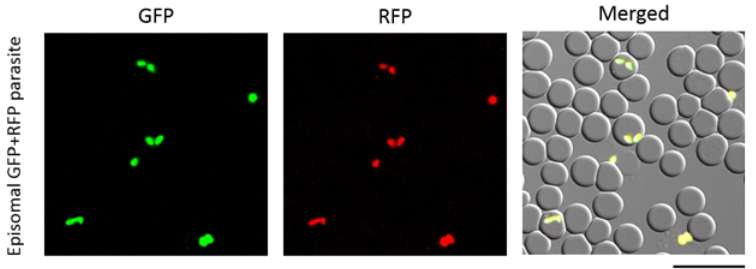
Fig 2. Live fluorescence images of B . bovis parasites. Parasites were episomally transfected with both RFP-BSD and GFP-hDHFR expression plasmids and selected with blasticidin-S and WR99210. Differential interference contrast and fluorescent images are merged on the right panel